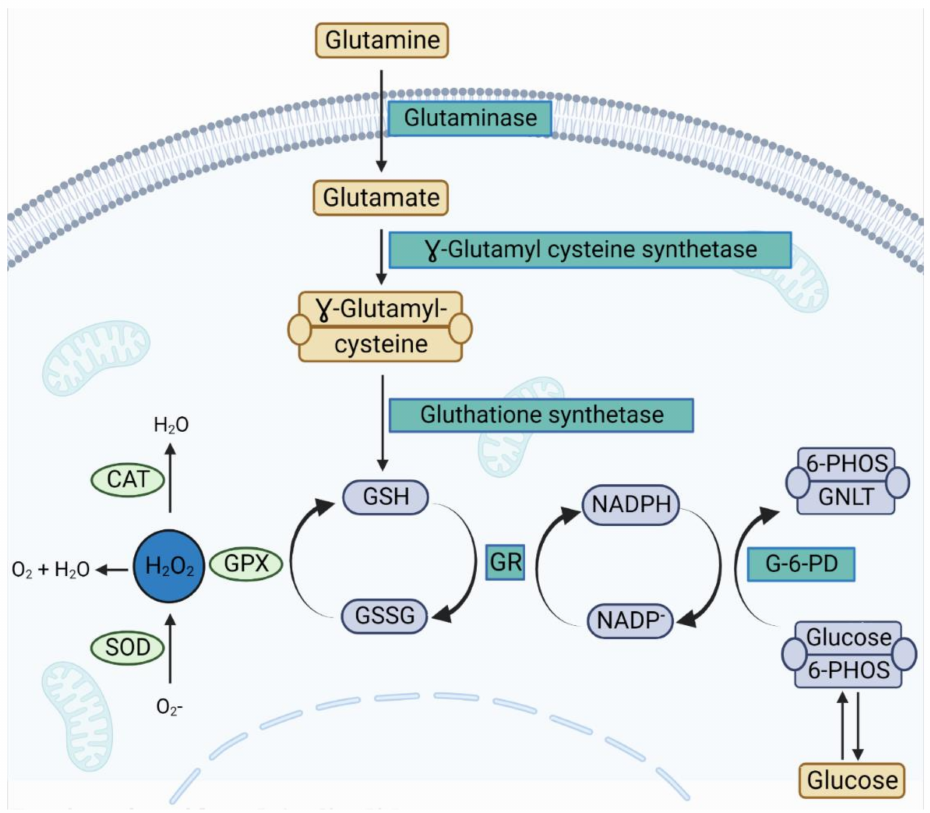
Figure 5. Involvement of glutamine in the antioxidant enzyme pathway. Glutamate is produced from glutamine via the action of phosphate-activated glutaminase. Thereafter, glutamate is converted into γ -glutamyl cysteine, which is the precursor of cellular glutathione (GSH). The three main antioxidant enzymes in the avian cell are glutathione peroxidase (GPX), superoxide dismutase (SOD), and catalase (CAT) [44]. GPX and CAT act synergistically to break down H 2 O 2 into water after the preceding action of SOD, which converts O 2- into H 2 O 2 . The action of GPX is linked to several other enzymes such as glutathione reductase (GR), and glucose-6-phosphate dehydrogenase (G-6-PD). However, it also requires cofactors, namely GSH, NADPH, and glucose-6-phosphate for optimal efficiency.